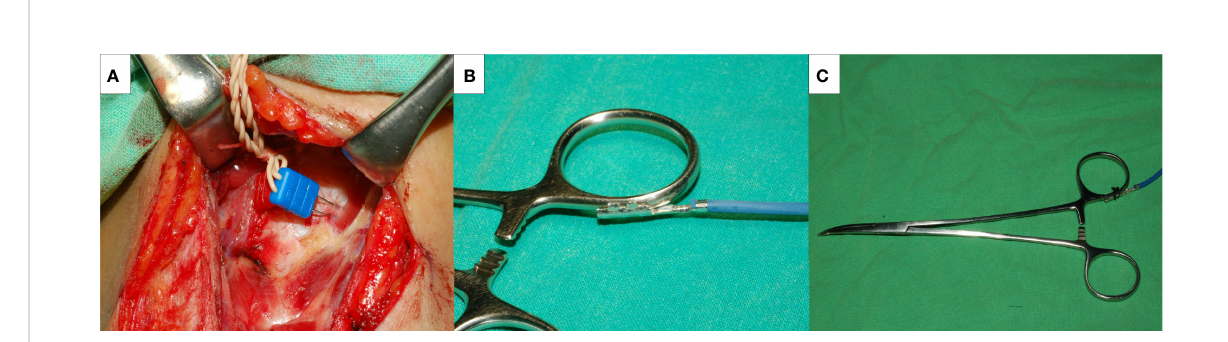
FIGURE 2 The novel intermittent intraoperative neuromonitoring method in this study. Medtronic two paired subdermal electrodes were inserted into the subperichondrium of the middle thyroid lamina for the EMG recording (A) . A Medtronic stimulation wire was connected to the conventional dissecting forceps (B) , and it became a stimulating dissecting instrument (C)